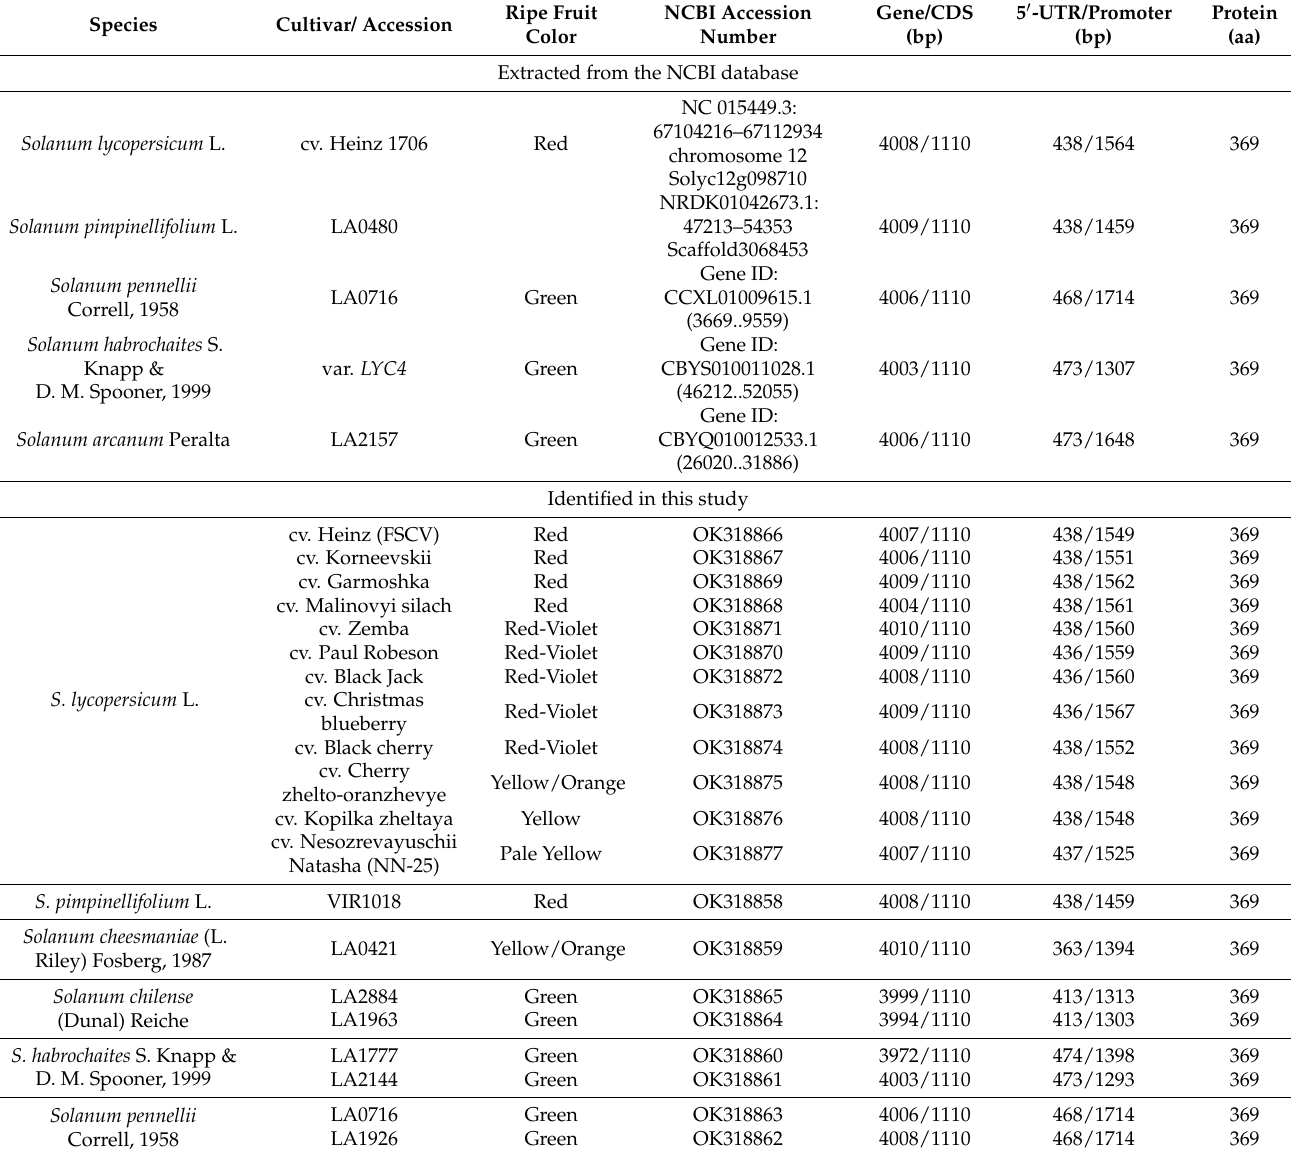
Table 1. Characteristics of Z-ISO genes in tomato cultivars and wild